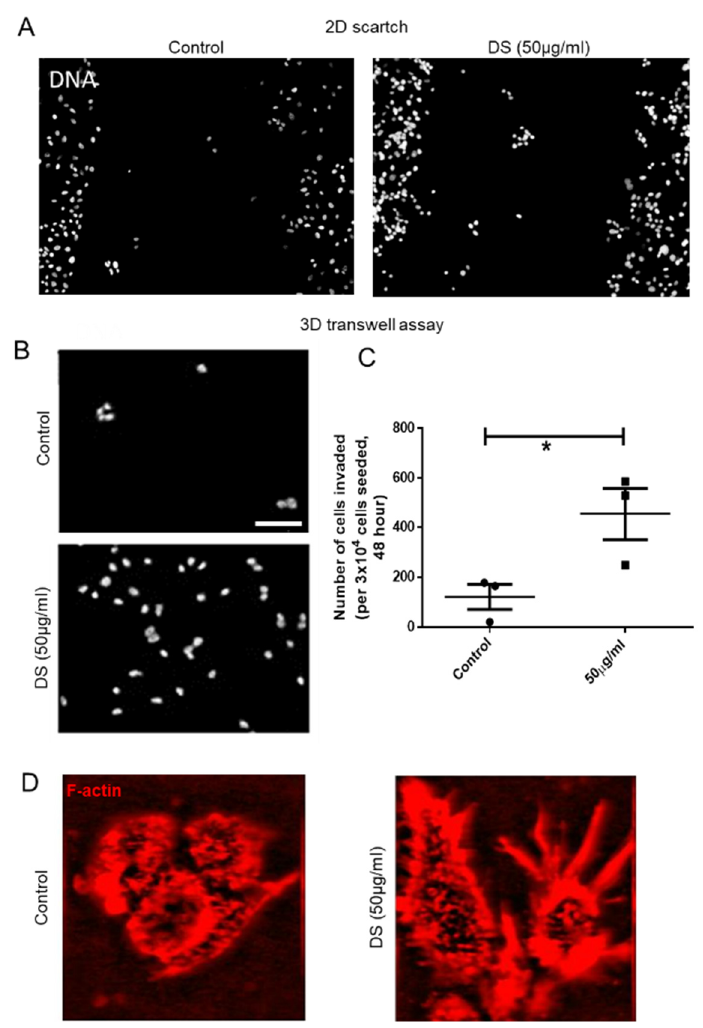
Figure 5. Increase in DS levels phenocopies IDS depletion and increases MCF-7 invasion. ( A ) Epifluorescence micrographs showing lack of migration of MCF-7 within scratches made in monolayers (left, control; right, upon treatment with 50 μ g/mL Dermatan Sulfate (DS)). The cells were visualized by staining DNA using DAPI. ( B ) Epifluorescence micrographs showing invasion of MCF-7 through Type 1 collagen-coated transwells (top, control; bottom, transwells coated with Type 1 collagen scaffold polymerized in the presence of 50 μ g/mL DS). The cells were visualized by using DNA stain DAPI. ( C ) Scatter plot showing the number of invaded cells in 5B. ( D ) Two-photon micrographs of MCF-7 cells cultured in 3D Type 1 collagen scaffold (left) and in 3D Type 1 collagen scaffolds polymerized in the presence of 50 μ g/mL DS (right) showing F-actin staining (using phalloidin, red) (lines in graphs represent mean ± SE of three independent experiments). Significance was measured using Student’s t test (* p < 0.05).